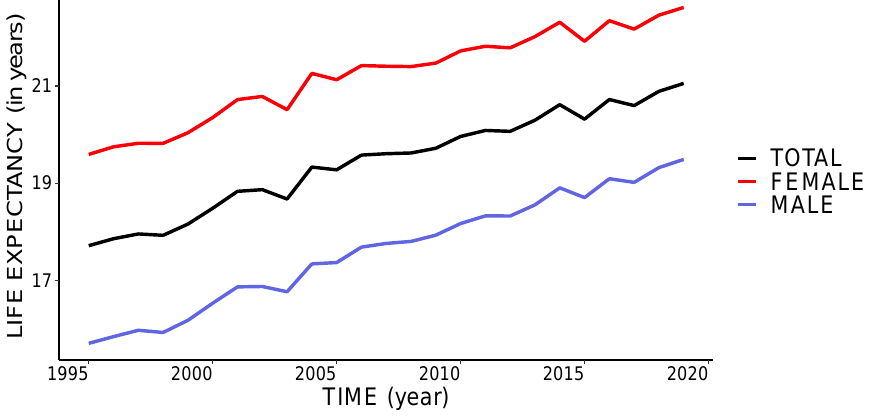
Figure 1. Life Expectancy at age 65 by gender in Italy during 1995–2019. Source: ISTAT (Supplementary